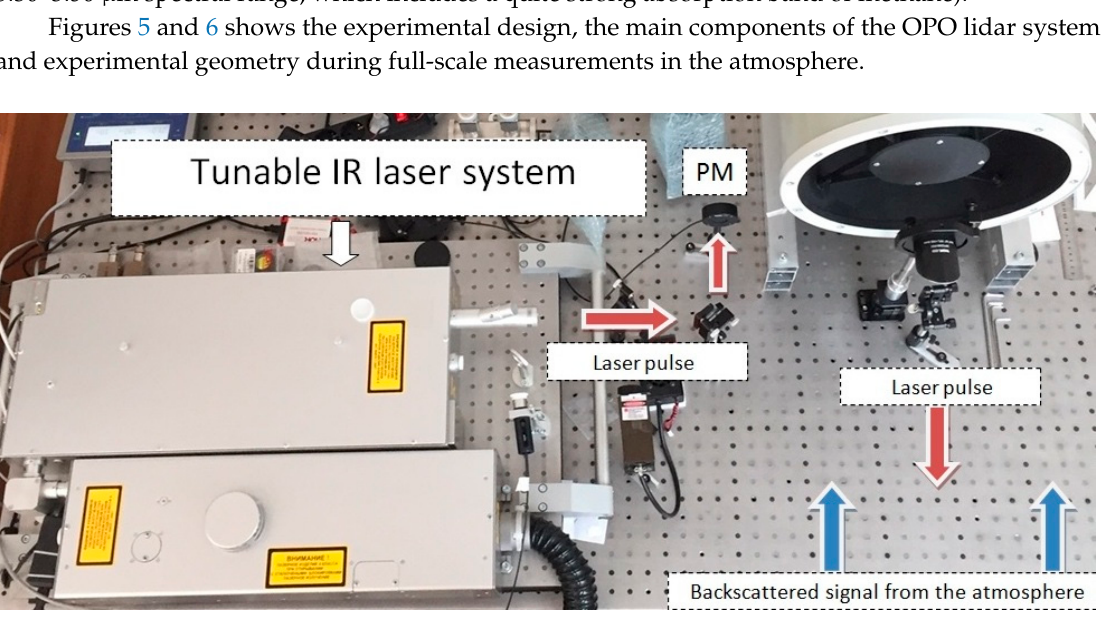
Figure 5. Tunable IR laser system and laser radiation direction.